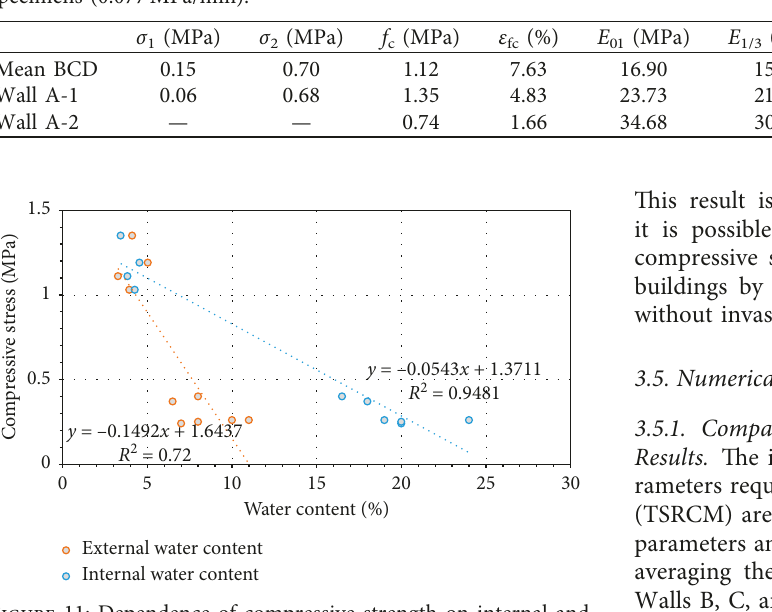
Figure 11: Dependence of compressive strength on internal and external water contents.